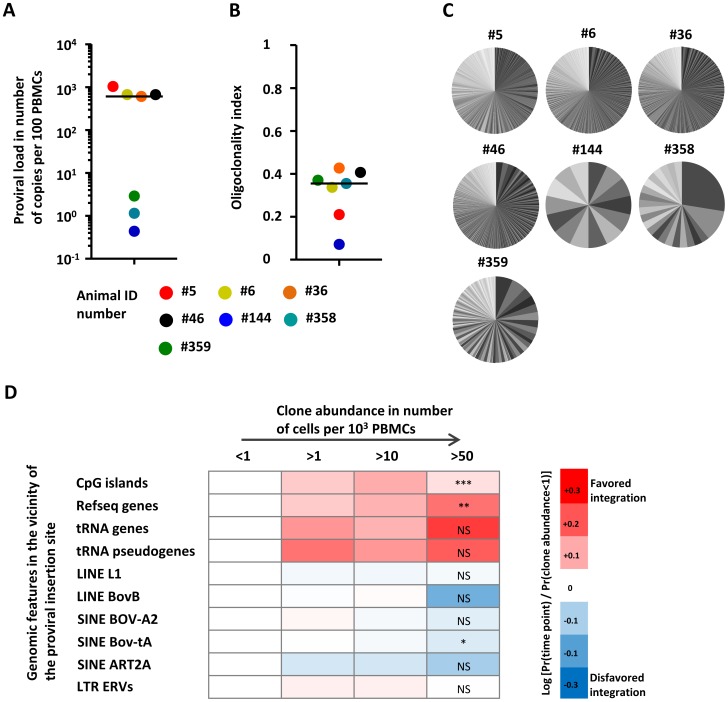
Evolution of provirus environment of clones with increasing abundance in long term infected animals.
A. Proviral load in long-term infected animals (i.e. infected for more than 2 years). Median is indicated by the horizontal black line. B. Oligoclonality index in the long-term infected animals. Median is indicated by the horizontal black line. C. The pie-charts depict the distribution of clone abundance for each animal. The size of each slice in the pie-charts represents the relative abundance of each BLV-infected clone. Note that although the gray tones are identical between different animals, the clones are different. D. Genomic heat map of integration preferences compared to the distribution observed in the lowest abundance clones (clone abundance less than 1 cell per 1000 PBMCs). Genomic features analyzed are shown to the left of the heat map. Gene and CpG proximity was calculated with a genomic interval of 50 kb. An interval of 5 kb was used for interspersed repeats. For each genomic feature, the integration frequency was examined for clones having a given abundance as shown at the top of the heat map. A colored scale is shown along the right hand side of the panel with increasing shades of blue indicating depletion compared to the distribution of the lowest abundance clones and increasing shades of red indicating enrichment. In the column at the highest clone abundance (clone abundance more than 50 cells per 1000 PBMCs), p-values are calculated by Chi-squared test for trend and show significance of the increasing or decreasing trend from the smallest clones. Data are representative for all 7 animals.